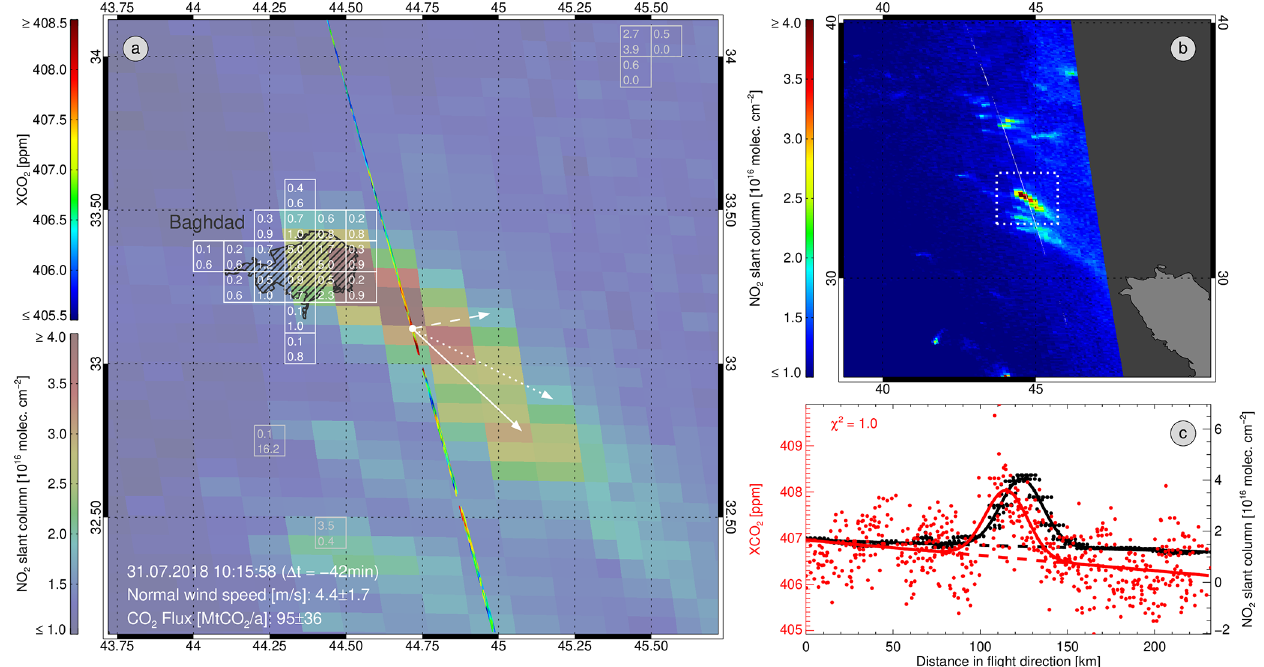
Figure 3. As in Fig. 1 but for Baghdad on 31 July